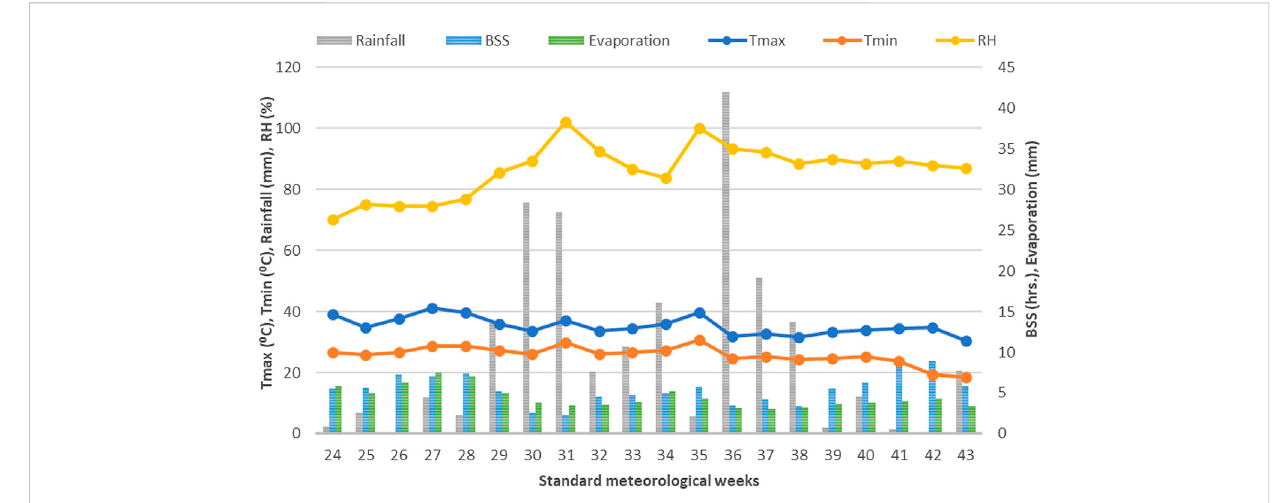
FIGURE 1 Average weekly rainfall, Tmax, Tmin, RH, evaporation, and BSS during crop growing season. Tmax: maximum temperature; Tmin: minimum temperature; RH: relative humidity; and BSS: bright sunshine hours